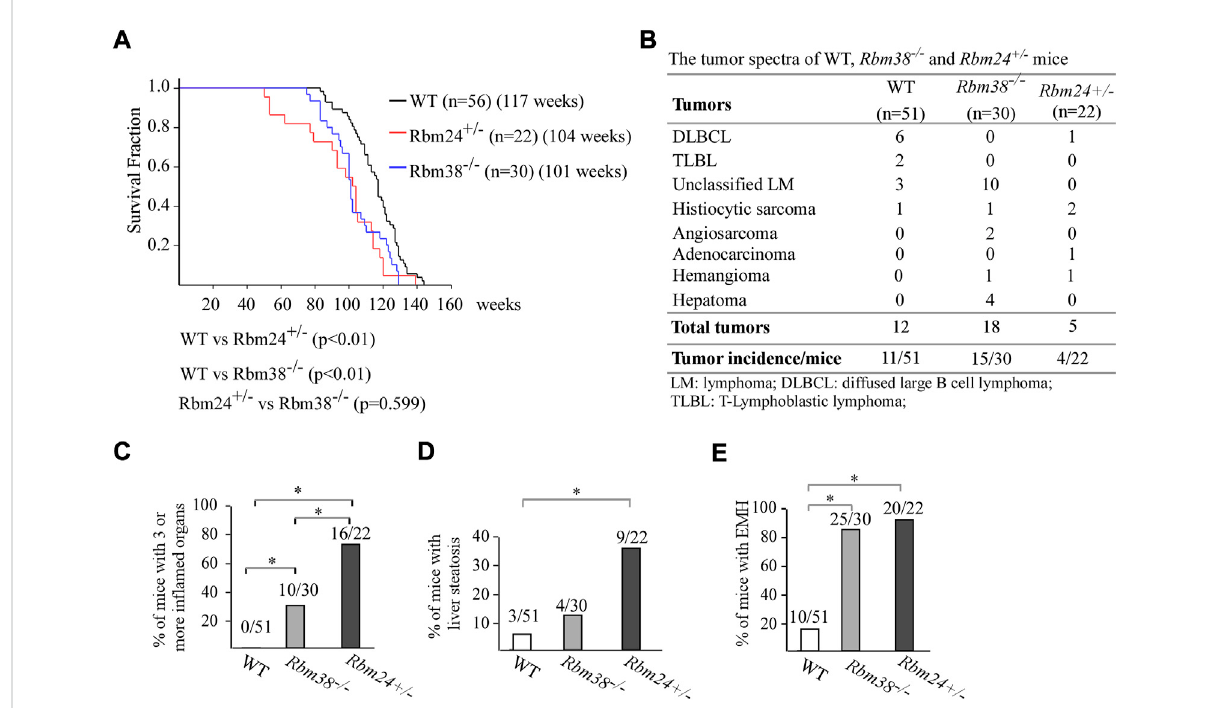
FIGURE 2 Micede fi cientin Rbm24 werepronetochronicin fl ammationandliversteatosis. (A) Kaplan-MeyersurvivalcurvesofWT(N=56), RBM24 +/ − (N= 22), AND RBM38 − / − (N = 30) MICE. p -value WAS CALCULATED BY LogRank Test. (B) Tumor spectra in WT (n = 51), Rbm24 +/ − (n = 22), and Rbm38 − / − (n = 30) mice. p = 0.76 (WT vs. Rbm24 +/ − ); p = 0.0131 (WT vs. Rbm38 − / − ); p = 0.0227 ( Rbm24 +/- vs Rbm38 − / − ) by Fisher ’ s exact test (C) Percentage of WT (n = 51), Rbm24 +/ − (n = 22), and Rbm38 − / − (n = 30) mice with 3 or more in fl amed organs. * indicated p < 0.05 by Fisher ’ s exact test. (D) PercentageofWT(n=51), Rbm24 +/ − (n=22),and Rbm38 − / − (n=30)micewithliversteatosis.*indicated p < 0.05byFisher ’ sexacttest. (E) Percentage of WT (n = 51), Rbm24 +/ − (n = 22), and Rbm38 − / − (n = 30)mice with extramedullary hematopoiesis (EMH). * indicated p < 0.05 by Fisher ’ s exact